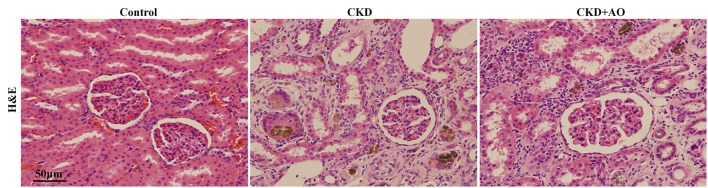
H&E staining of kidney tissue. Representative images of H&E stained kidney sections from control, adenine-induced CKD and CKD+AO groups.